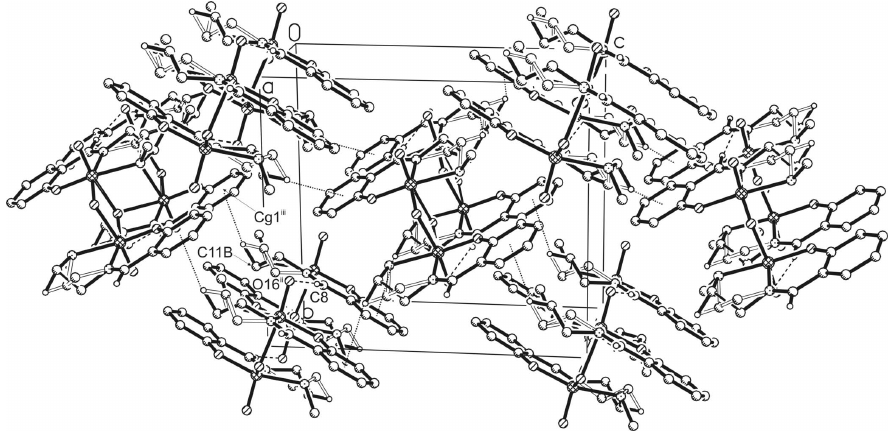
The molecular structure of the title compound, with displacement ellipsoids drawn at the 25% probability level. [Symmetry code: (i) -x, -y+2, -z.]